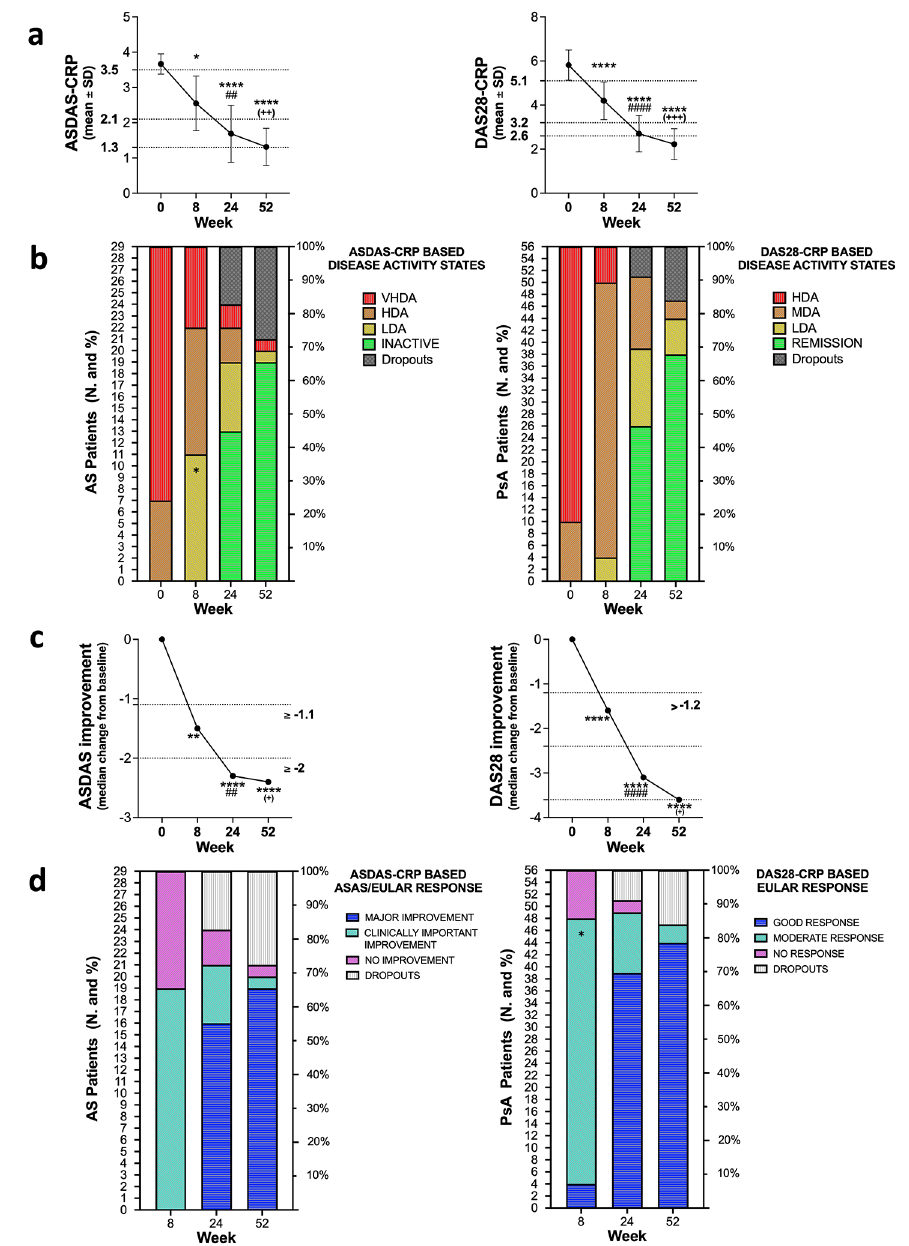
Fig. 1 Disease activity scores and treatment responses in patients with AS or PsA during therapy with secukinumab. a) Mean values (± stan- dard deviation) of ASDAS-CRP and DAS28-CRP at baseline and at 8, 24 and 52 weeks of treatment in patients with AS and PsA, respectively. * P < 0.05, **** P < 0.0001 (compared to week 0); ## P < 0.01, #### P < 0.0001 (week 24 vs. 8); ++ P < 0.01, +++ P < 0.001 (week 52 vs. 24). b) Numbers and percentages of AS or PsA patients with different disease activity states according to ASDAS and DAS28 cut-offs. VHDA, very high disease activity (ASDAS > 3.5); HDA, high dis- ease activity (2.1 ≤ ASDAS < 3.5 or DAS28 > 5.1); MDA, moderate disease activity (3.2 < DAS28 ≤ 5.1); LDA, low disease activity (ASDAS < 2.1 or DAS28 ≤ 3.2); inactive disease or remission (ASDAS < 1.3 or DAS28 < 2.6). * P < 0.05 (LDA at week 8 in AS vs. PsA). c) Median changes of ASDAS-CRP and DAS28-CRP at the various time points in patients with AS and PsA, respectively. ΔASDAS ≥ 1.1, clinically important improvement; ΔASDAS ≥ 2, major improvement; ΔDAS28 > 1.2, moderate response with current DAS28 > 3.2 or good response with current DAS28 ≤ 3.2. ** P < 0.01, **** P < 0.0001 (compared to week 0); ## P < 0.01, #### P < 0.0001 (week 24 vs. 8); + P < 0.05 (week 52 vs. 24). d) Numbers and percentages of AS or PsA patients with different treatment responses according to ASAS and EULAR criteria (see above cut-offs). * P < 0.05 (significant responses at week 8 in PsA vs.